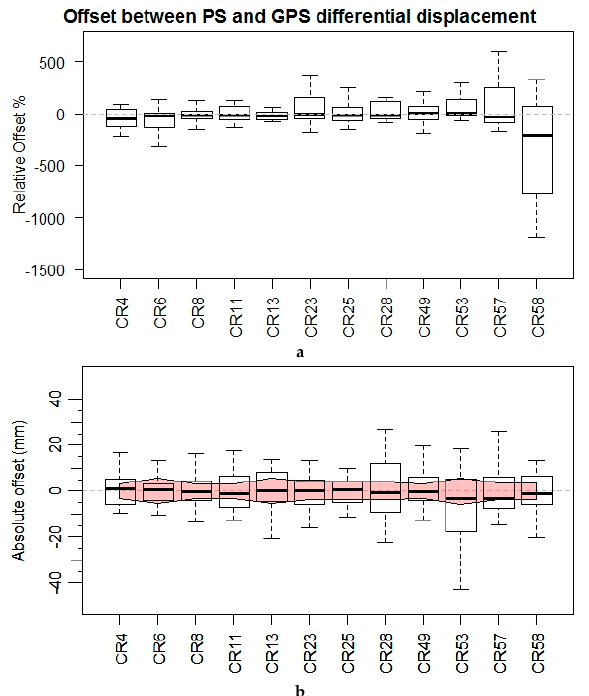
Figure 8. Evaluation of PS-MTI and GPS-LOS differential displacement time-series: ( a ) relative offset; and ( b ) absolute offset. The red shaded area represents the median GPS error computed for each monitoring point. Boxplots represent the 1st and 3rd quartiles (limiting the top and bottom of the boxes) and the median (2nd quartile) is depicted by the black horizontal line. Whiskers represent the difference between the 1st quartile and 1.5 times the IQR, bottom whisker, and the 3rd quartile minus 1.5 times the IQR, top whisker.